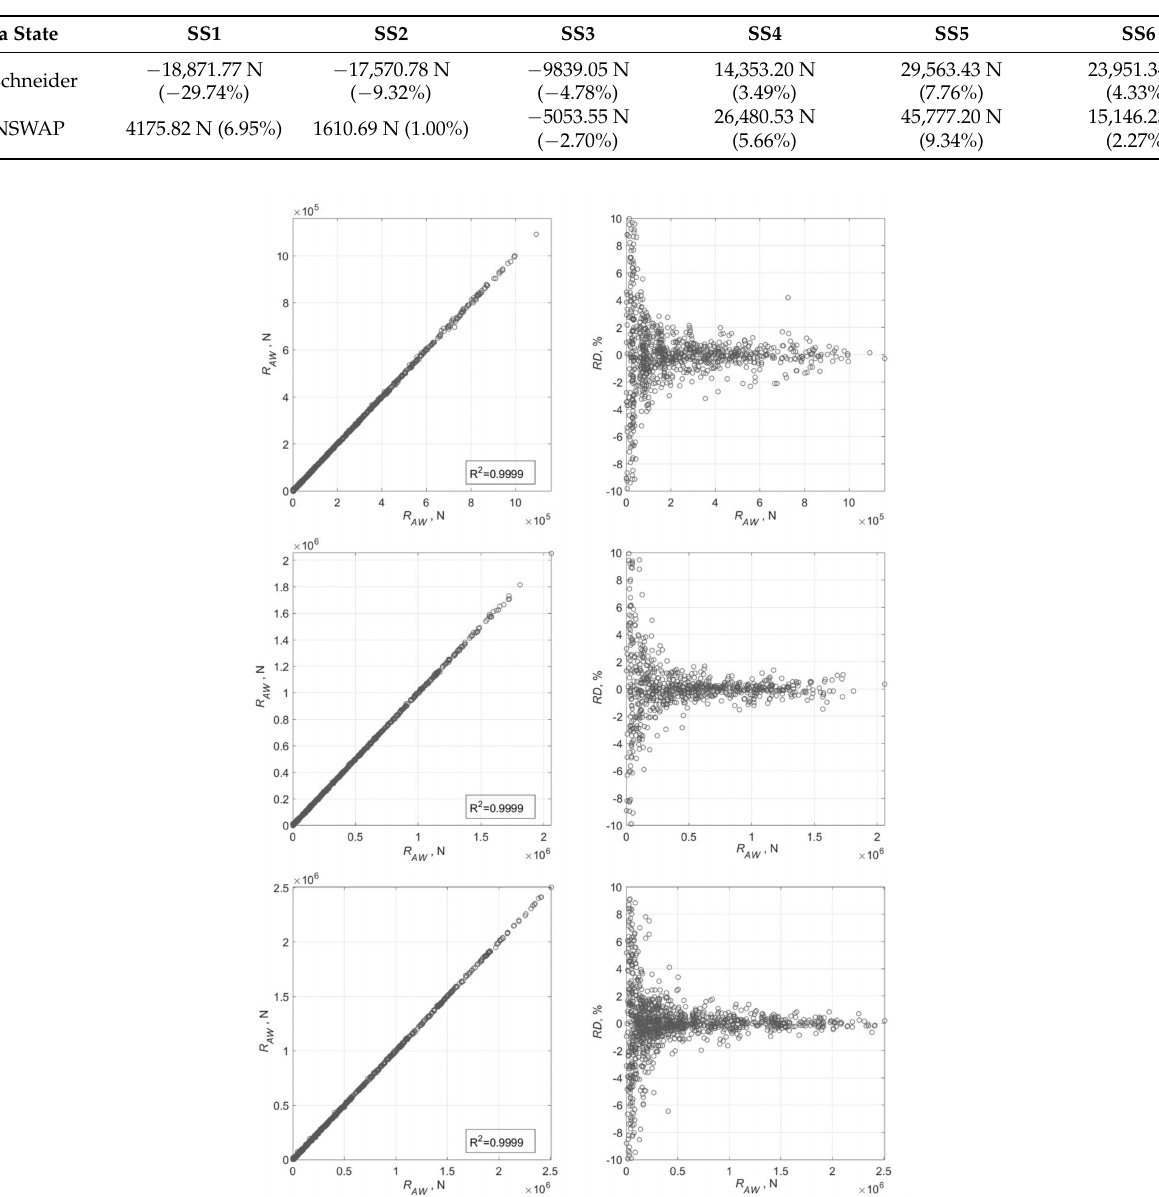
Figure 13. The comparison of the results obtained by ANN and BIEM for KCS for the Bretschneider ( left ) and JONSWAP ( right ) wave energy spectra. Table 6. The absolute and percentage differences between the results obtained by ANN and BIEM for KCS.